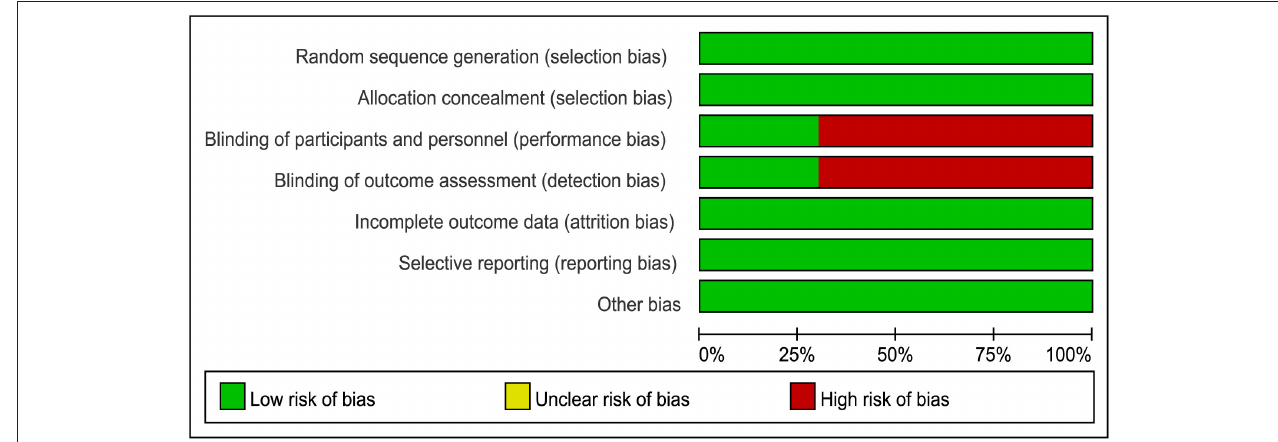
FIGURE 1 | Judgment of risk of bias for each item presented as percentages across all eligible